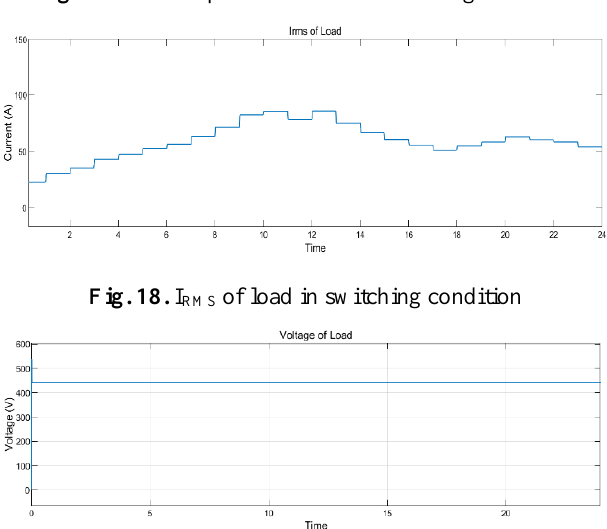
Fig. 19. V RMS of load in switching condition